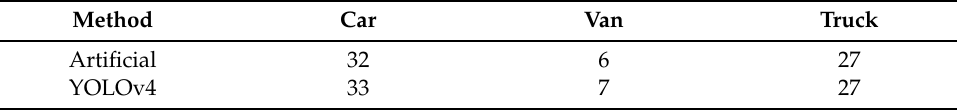
Figure 5. Vehicle Detection. ( a ) The original imge, ( b ) The resized image, ( c ) Resized image to be deteced, ( d ) Recovered to final result. Table 3. Results for the crack detection of four different